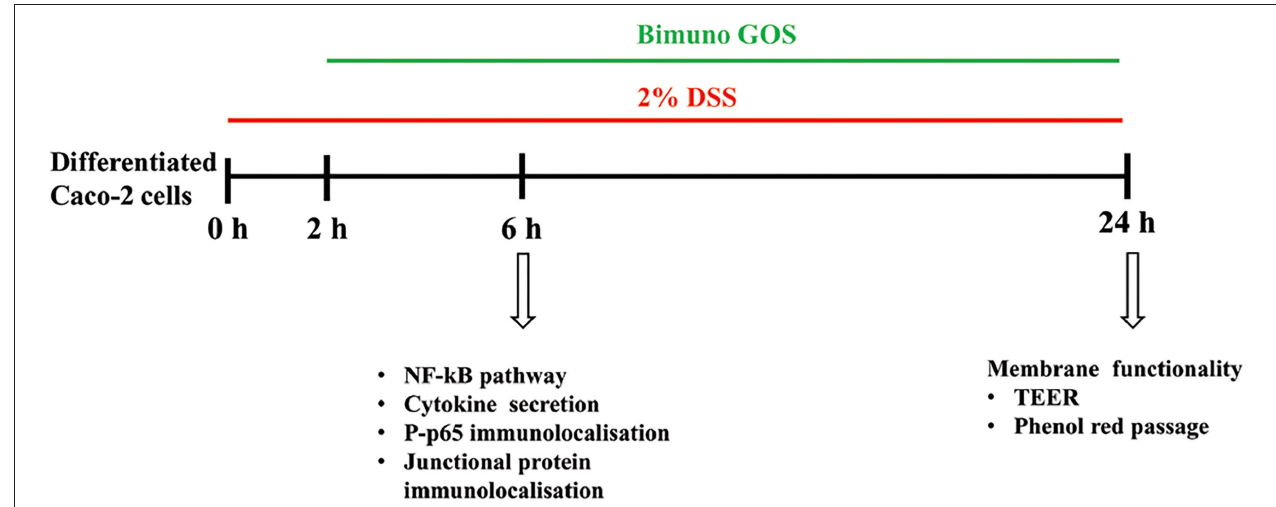
FIGURE 1 | Experimental design. Three different experimental setups were employed, as differentiated Caco-2 cells were: (1) treated with 2% dextran-sulfate-sodium salt (DSS) alone (6 or 24h), (2) treated with 2% DSS for 2h, then several Bimuno galactooligosaccharides (GOS) concentrations (1–1,000 µ g/ml) were added for further 4 or 22h, or (3) treated with different Bimuno GOS concentrations alone (4 or 20h). The different analyses performed at each time point are indicated.